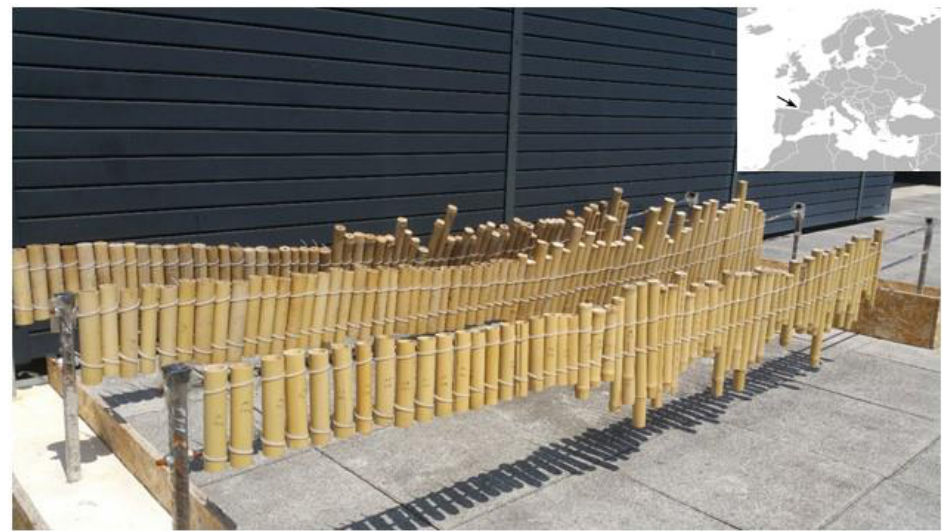
Figure 1. The 6 month weather exposure durability test and geographical location of the test (see map in upper right).